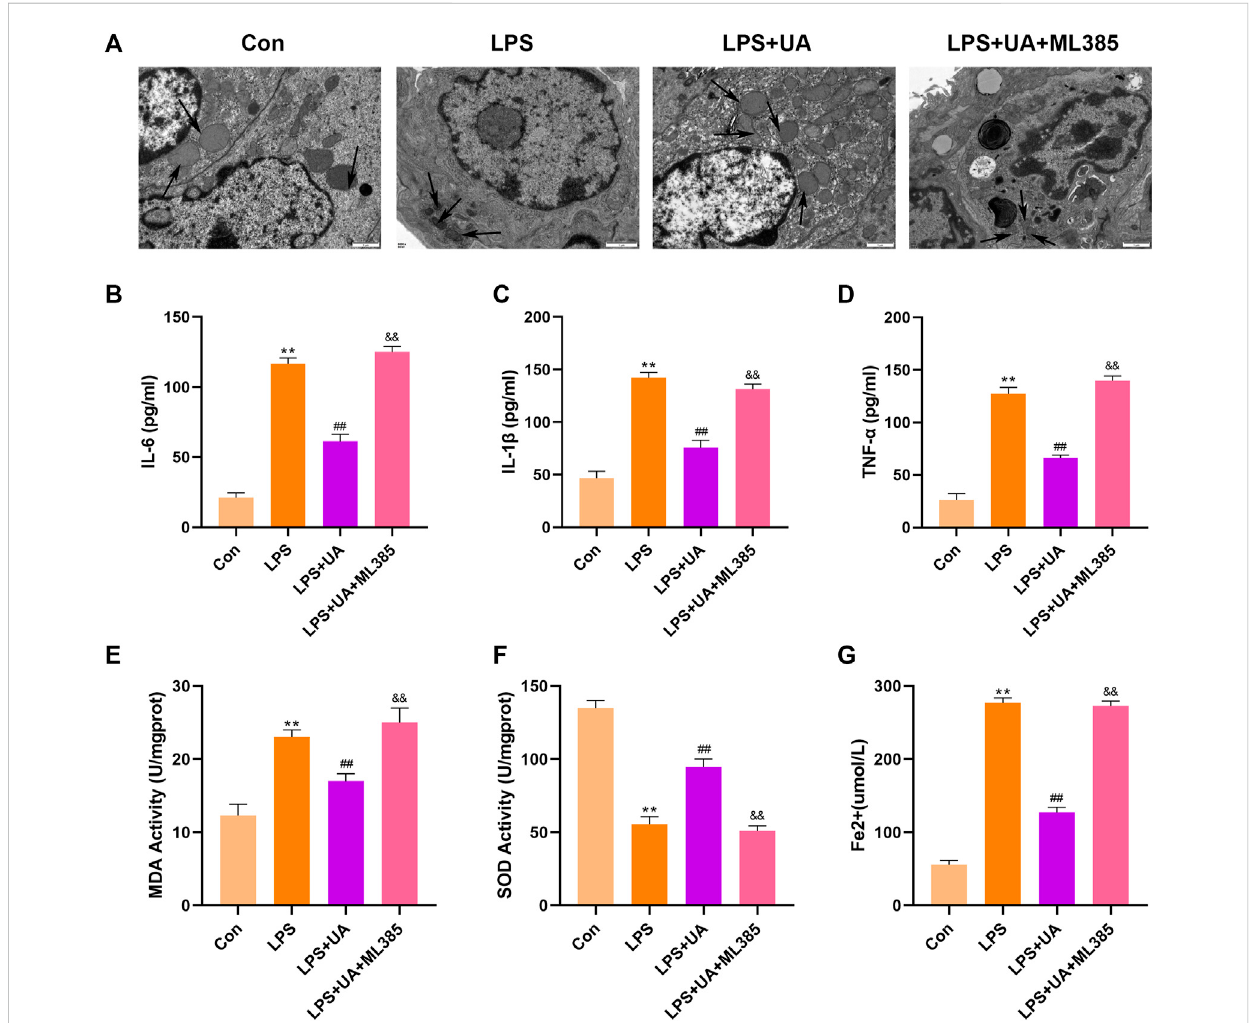
FIGURE 8 Urolithin A (UA) inhibited ferroptosis by activating Nrf2. (A) Typical TEM images showed ferroptosis in the lung tissues. (B – D) TNF- α , IL-1 β , and IL-6 concentrations in the supernatants BEAS-2B cells. (E,F) SOD and MDA activities in lung tissues. (G) Fe 2+ expression in BEAS-2B cells. The results were represented by mean ± SD. ## p < 0.01, ** p < 0.01, && p < 0.01 in comparison to control, LPS and LPS + UA groups,